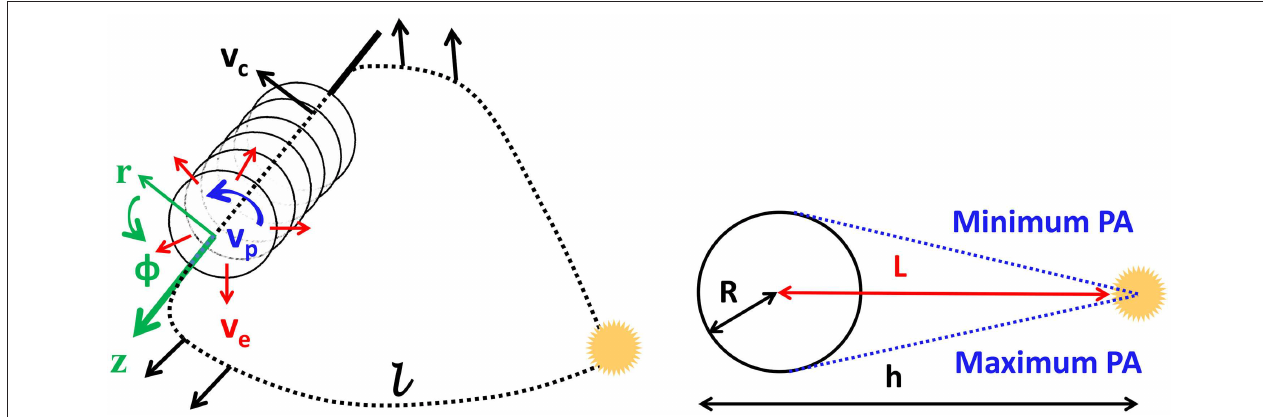
FIGURE 1 | Left : A representative picture of a CME flux rope. The black dashed line indicates the looped axis of the flux rope with the axial length as l . A cylindrical coordinate system (i.e., r , φ , z ) is attached to the axis of the flux rope (in green). Right : A representative picture for the cross-section of the CME flux rope. The radius of the flux rope is R , the distance from the flux rope axis to the solar surface is L , the distance of the CME leading edge from the Sun’s center is h , and the minimum and the maximum position angles (PA) are shown with dotted blue lines (adapted from Mishra and Wang,